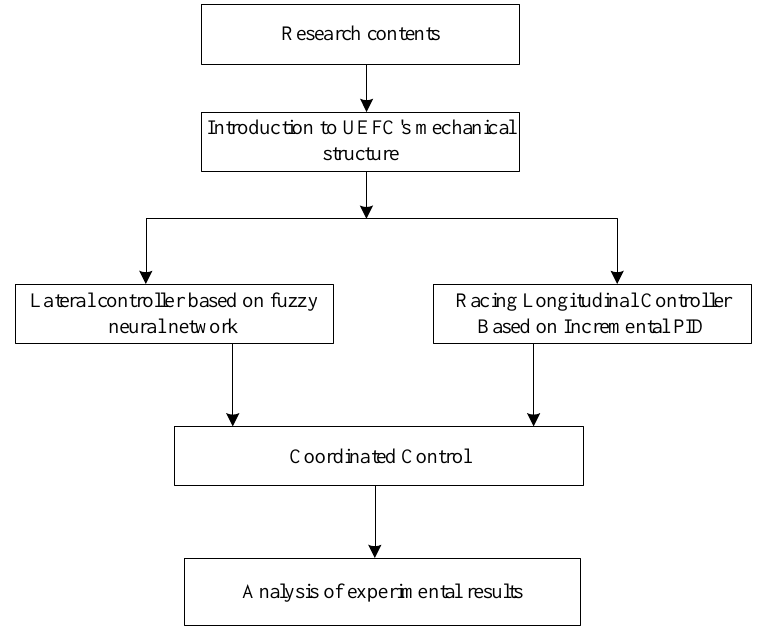
Figure 1. Main contents of this